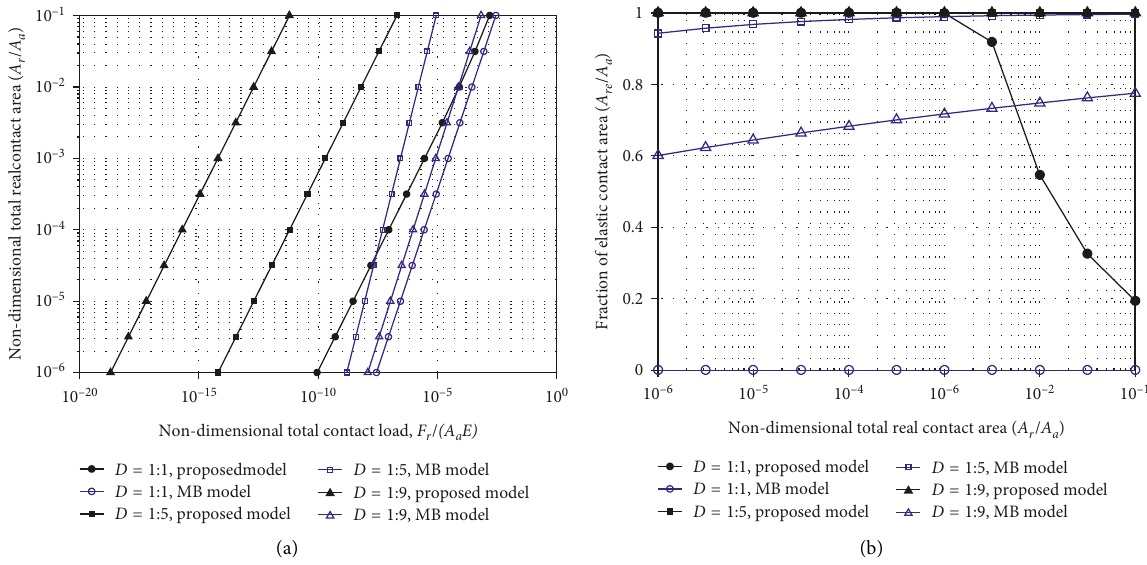
Figure 13: Comparison of the proposed model and the MB model (a) on the relationship between nondimensional total contact load and nondimensional total real contact area and (b) on the relationship between nondimensional total real contact area and the fraction of elastic contact area for different fractal dimensions ( n